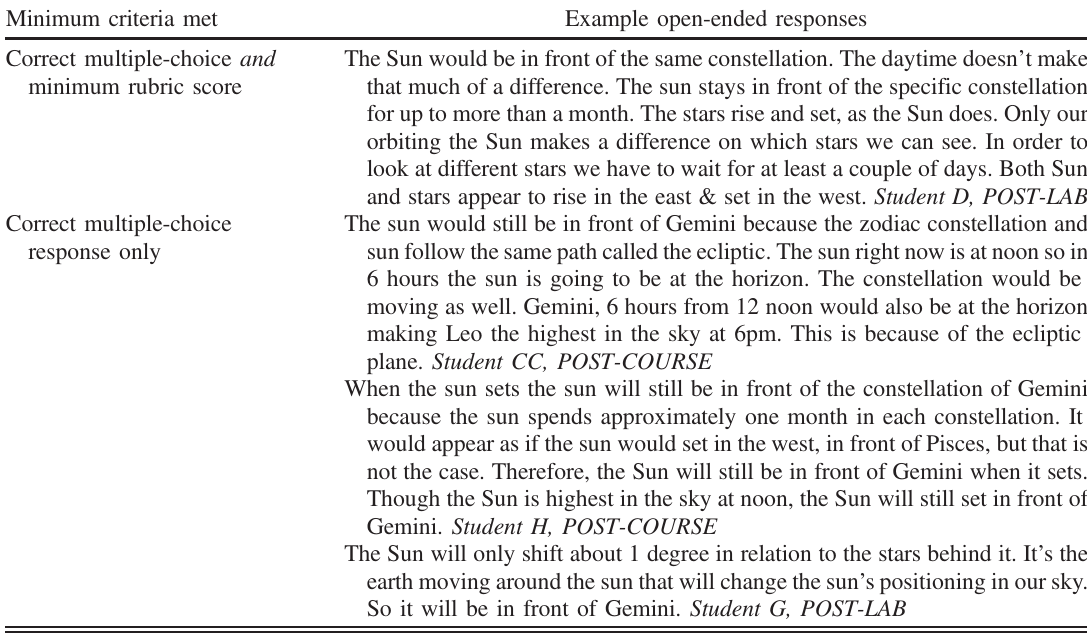
TABLE VII. Example open-ended responses given for the assessment regarding the apparent motion of the Sun with respect to the stars over the course of a